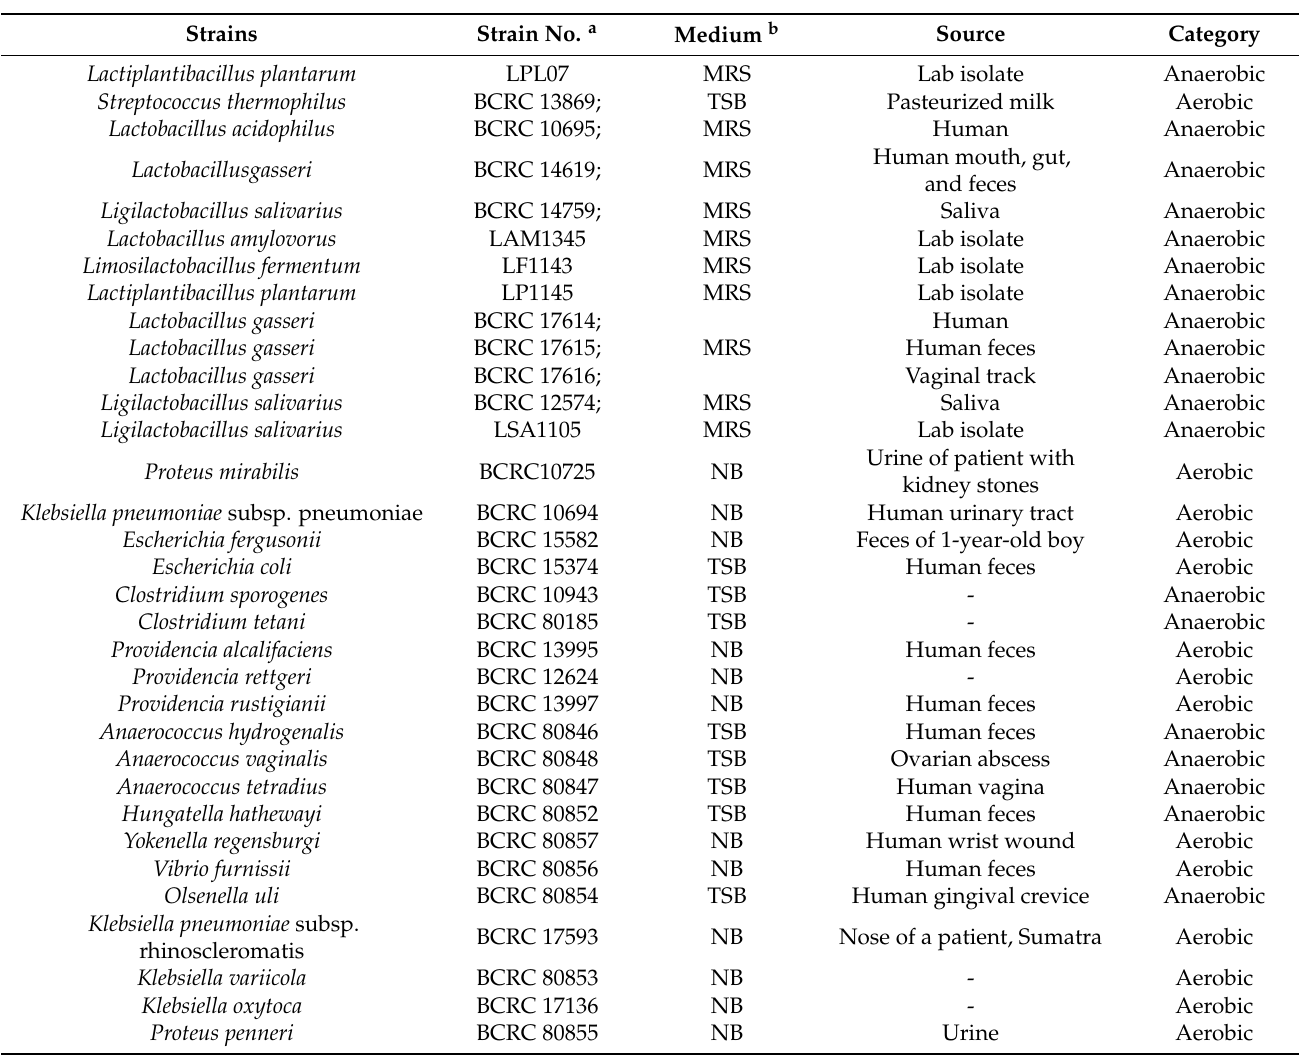
Table 1. List of bacterial strains used in the present